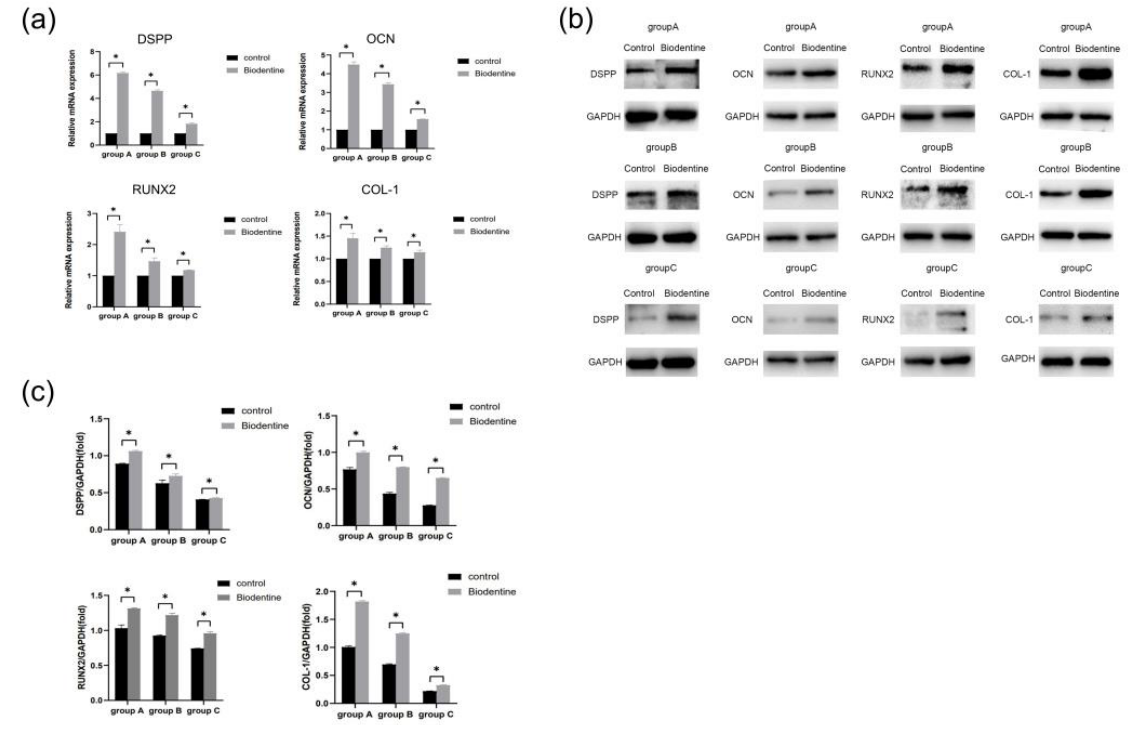
Figure 9. Effects of Biodentine on the odontogenic/osteogenic differentiation of hDPSCs. ( a ) The mRNA expression levels of DSPP, OCN, RUNX2, and COL-1 detected by qRT-PCR analysis on day 7. ( b ) The protein expression of DSPP, OCN, RUNX2, and COL-1 detected by Western blot analysis on day 14. ( c ) Quantitative analysis of DSPP, OCN, RUNX2, and COL-1 immunoblot. * p < 0.05, versus control.